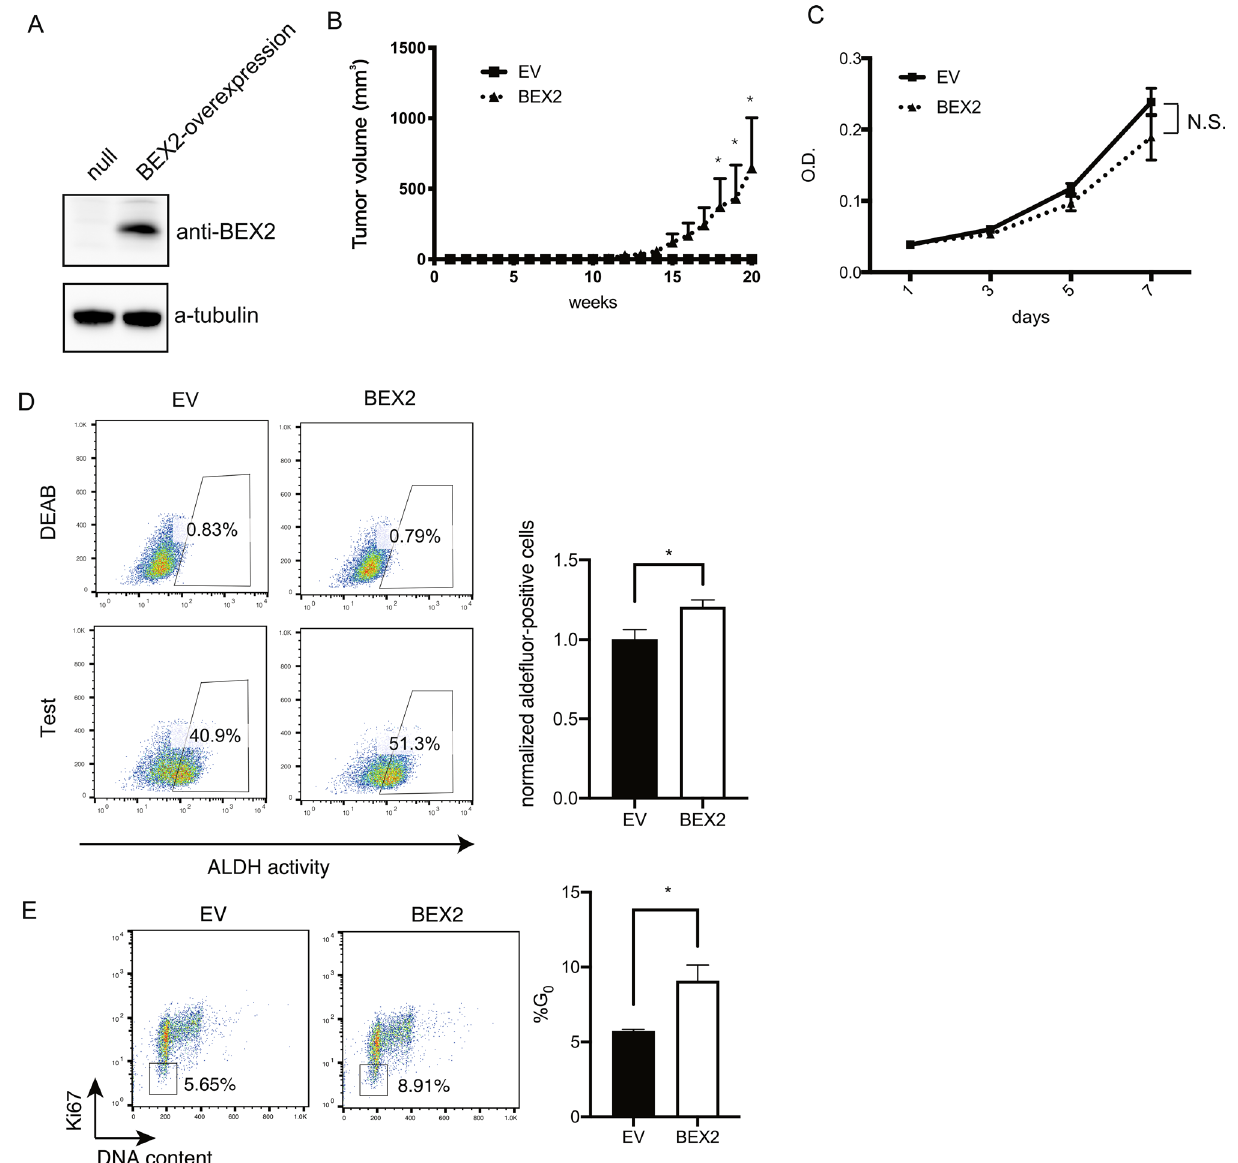
Figure 2. Overexpression of BEX2 increased dormant cancer stem cells. ( A ) Western blotting analysis of control and BEX2-overexpressing HuCCT1 cells. ( B ) Tumorigenicity assay of BEX2-overexpressing and control HuCCT1 cells. A total of 10 2 HuCCT1-BEX2 or control cells were subcutaneously injected into NOG mice and the diameter of tumors was measured; n = 6. *P < 0.05. ( C ) Cell proliferation curve of BEX2-overexpressing and control HuCCT1 cells was determined by MTT assay; n = 3. N.S., not significant. ( D ) ALDH activity was determined with an ALDEFLUOR assay in BEX2-overexpressing and control HuCCT1 cells. ALDH activity was increased in BEX2-overexpressing HuCCT1 cells. ALDH-positive gates were determined with DEAB treatment. SSC, side scatter. Test, assay without DEAB treatment. (left panel) Representative graphs of ALDH assay; (right panel) summary of the positivity of ALDH. *P < 0.05. ( E ) Cell cycle assay of HuCCT1 cells cultured in medium containing 0.1% FBS for 24 h, and then fixed with 70% ethanol and stained with PI and Ki67 for flow cytometry sorting. G 0 phase (open square) was increased in BEX2-overexpressing HuCCT1 cells. (left panel) Representative graphs of cell cycle analysis; (right panel) summary of the percentage of G 0 fraction. *P <